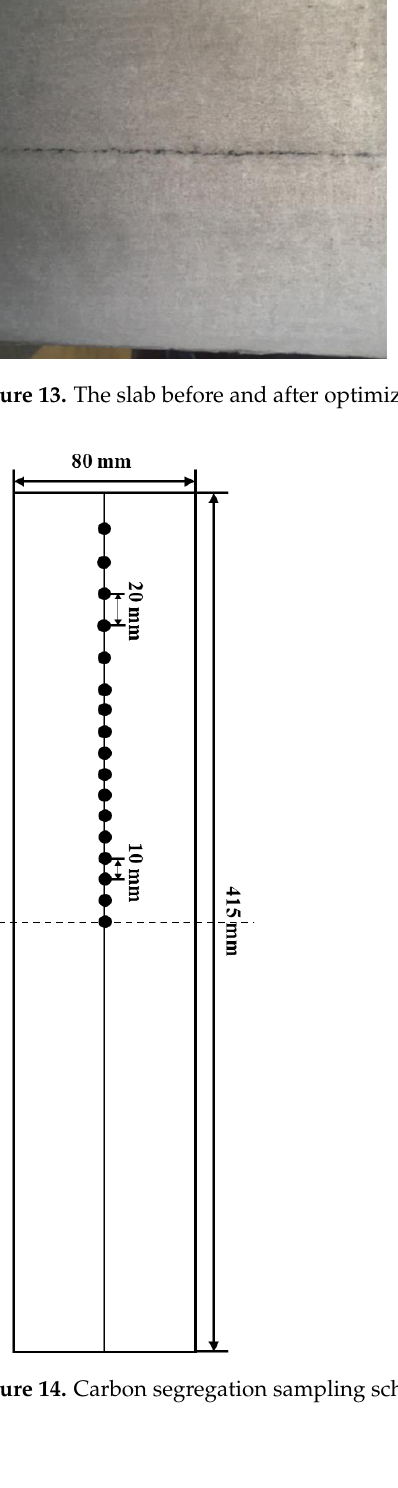
Table 6. The soft reduction parameters after optimization.